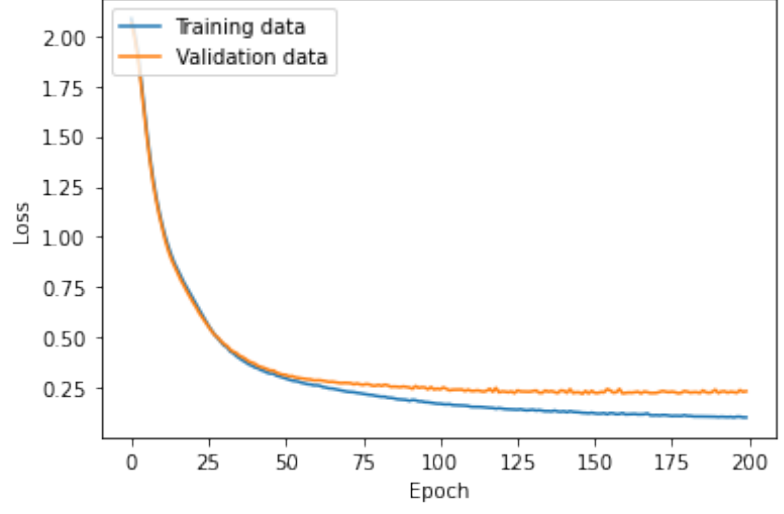
Figure 10. Model ANN(10, 10, 10) Loss curve.